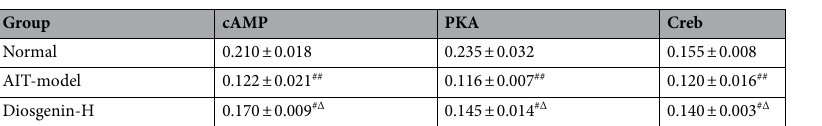
Table 4. cAMP, PKA and Creb IOD/Area expression in thyroid tissue ( ¯ x ± SD , n = 3). Note: # Compared with normal group, P < 0.05; ## compared with the normal group, P < 0.01; Δ Compared with the model group, P < 0.05; ΔΔ Compared with the model group, P <